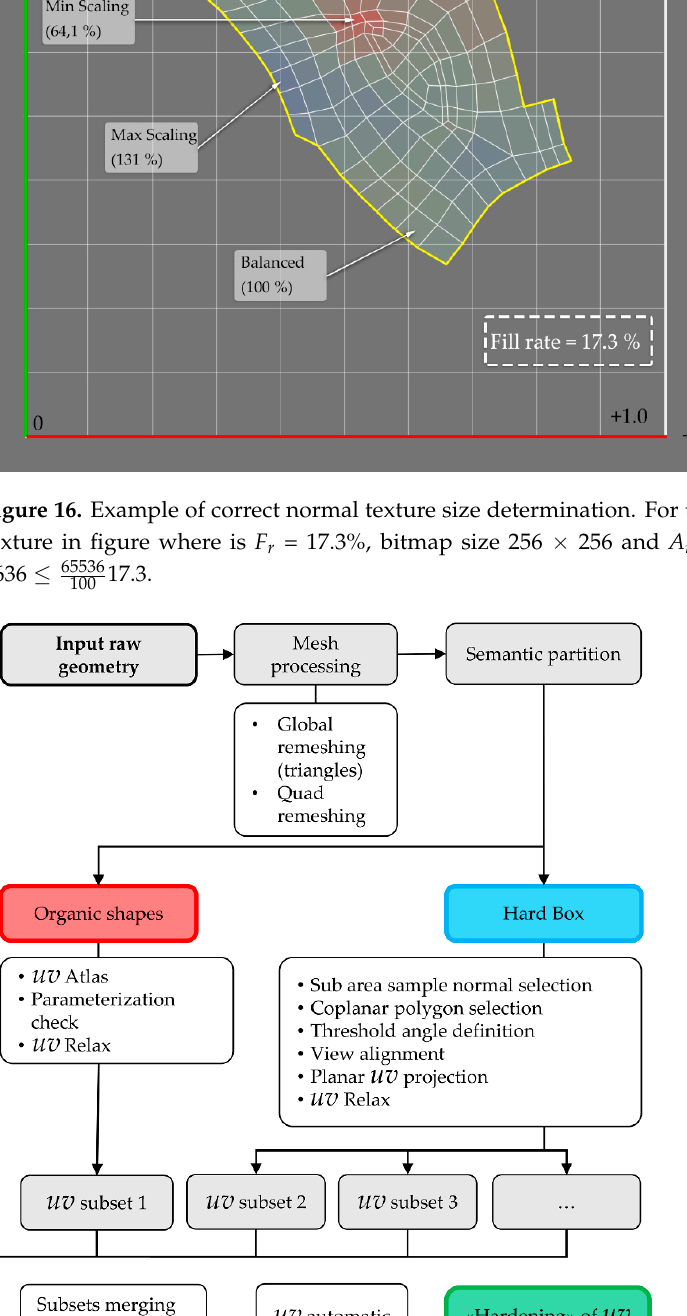
Figure 17. The automatic modelling steps (global remeshing and quad-remeshing).